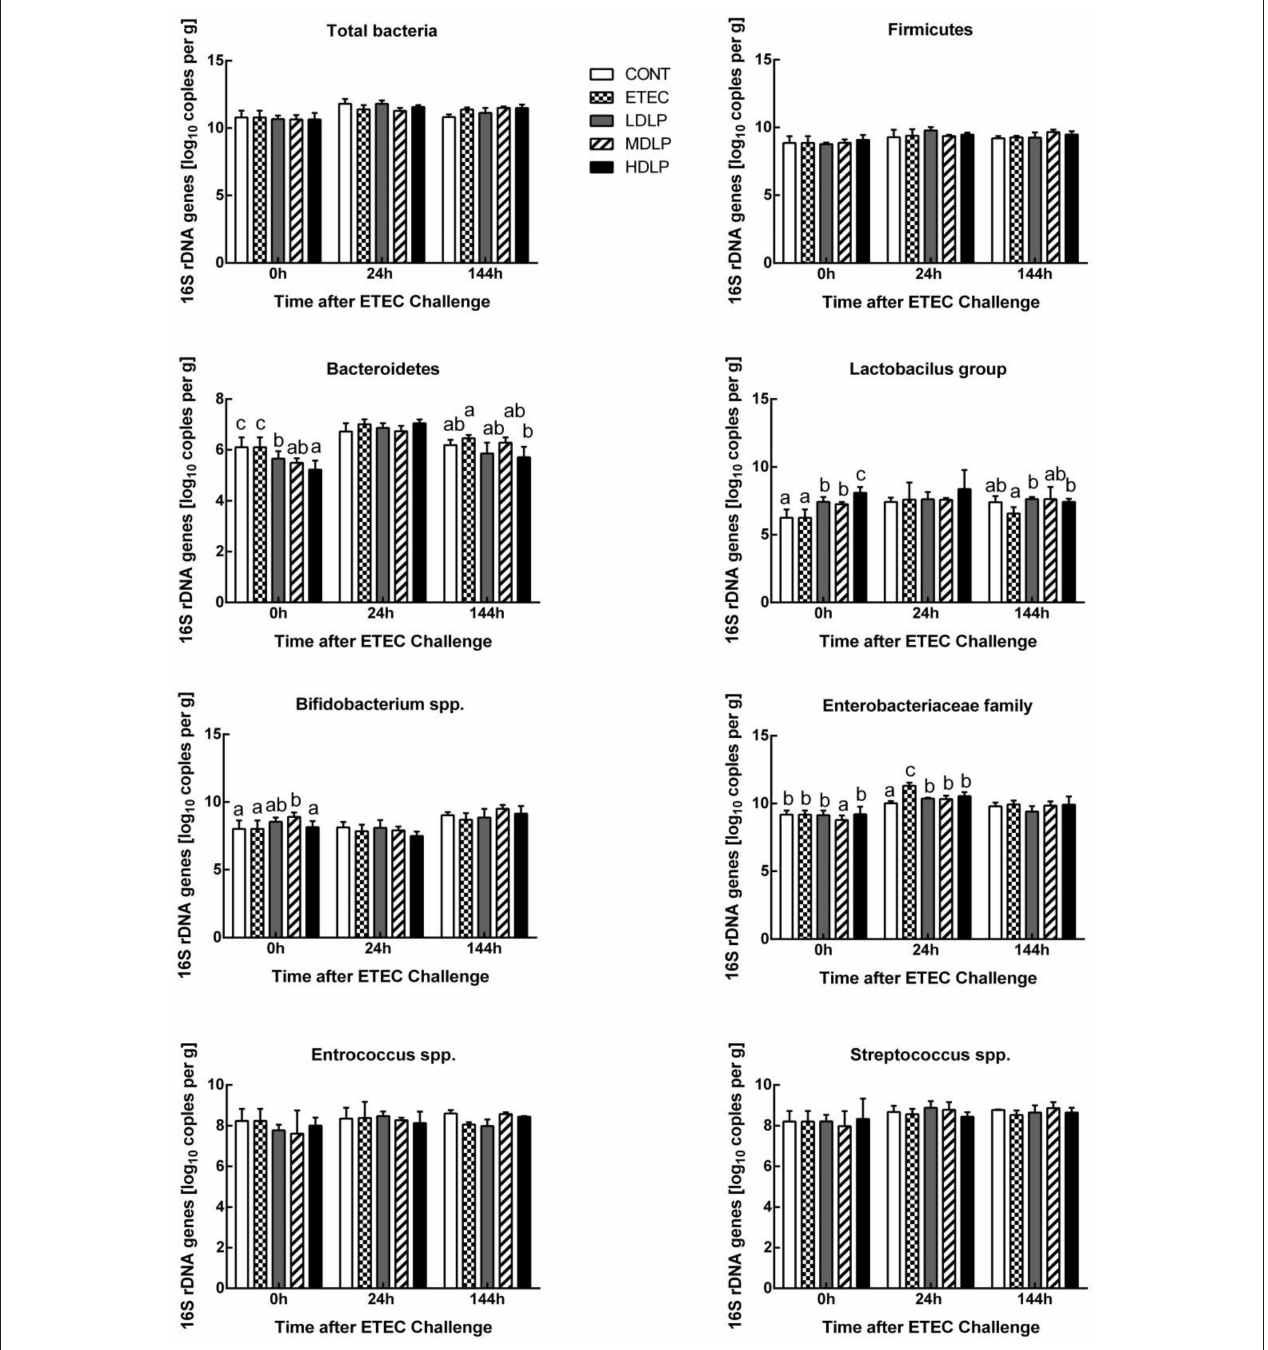
FIGURE 7 | Dose effect of Lactobacillus plantarum on composition of the mice colonic microbiota during pre- and post-challenge periods. CONT, control group, treatment with PBS at all period; ETEC, negative group, oral challenge with ETEC on day 15; LDLP, low dose (5.0 × 10 8 cfu mL − 1 ) group; MDLP, intermediate dose (5.0 × 10 9 cfu mL − 1 ) group; HDLP, high dose (5.0 × 10 10 cfu mL − 1 ) group; LDLP, MDLP, and HDLP groups were infected with ETEC at day 15. Bars with different letters are significantly different ( P < 0.05). Bars share the same letters do not differ significantly ( P >